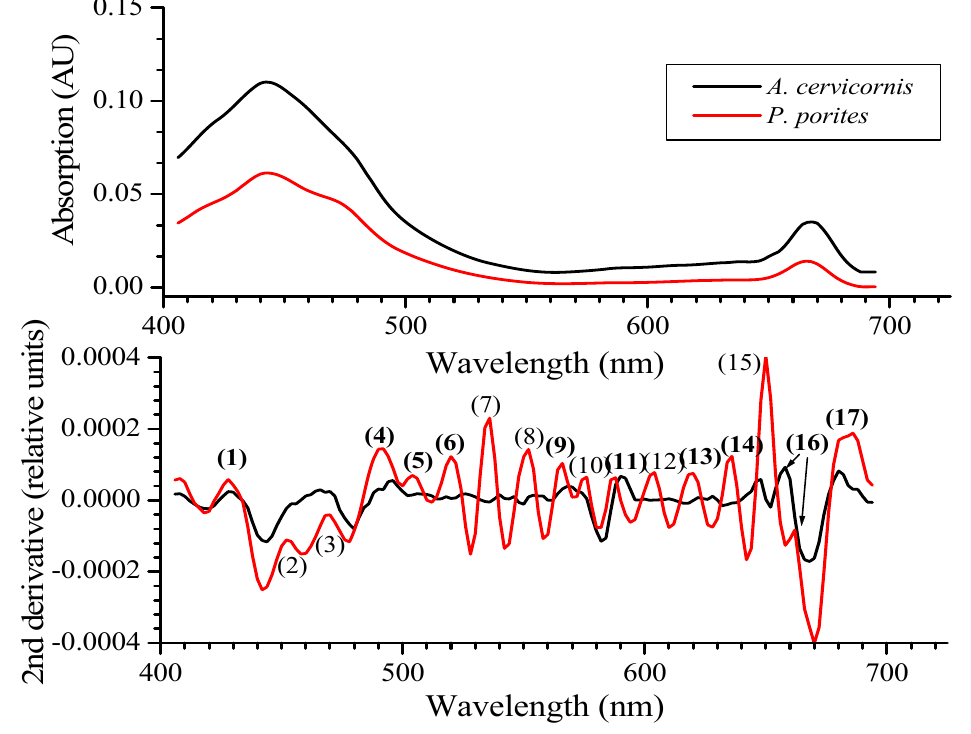
Figure 6. Average absorption spectra (n = 5) for A. cervicornis and P. porites with their respective 2nd derivative. The numbers in parenthesis in the derivative graphs represent peaks at specific wavelengths (nm): (1) 424, (2) 452, (3) 468, (4), 490, (5) 507, (6) 518, (7) 534, (8) 551, (9) 561, (10) 575, (11) 586, (12) 604, (13) 616, (14) 632, (15) 649, (16) 658 ( A. cervicornis ) and 661 ( P. porites ) and (17) 680. Note the hypsochromic shift of absorption peaks (numbers in bold) that are also present in the coral’s reflectance curves shown in Figures 4 and